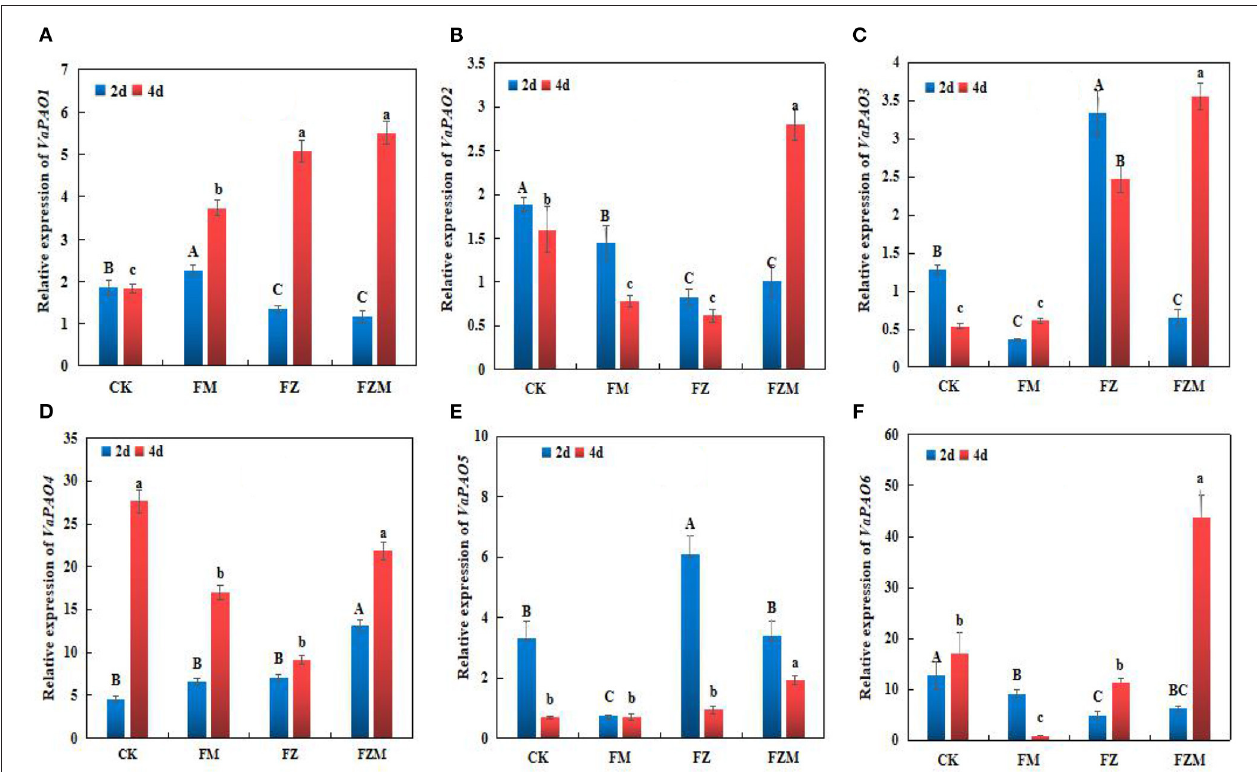
FIGURE 7 | (A) VaPAO1 , (B) VaPAO2 , (C) VaPAO3 , (D) VaPAO4 , (E) VaPAO5 , and (F) VaPAO6 relative expression in germinating adzuki beans. Upper and lower case letters in the figure reflect significant differences between 2 and 4 d germination treatments ( p < 0.05). CK: Control treatment (31 ◦ C for 4 d); FM: 2 mg/ml MSG treatment; FZ: 15h vacuum treatment; FZM: 15h vacuum + 2 mg/ml MSG treatment (sprayed every